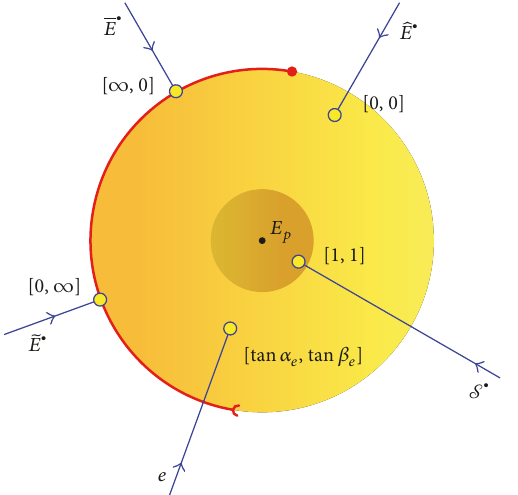
Figure 15: The projective disk on the celestial hemisphere C 퐸 centered at 𝐸 푝 and the four canonical projective points and the corresponding projective point for 𝑒 .